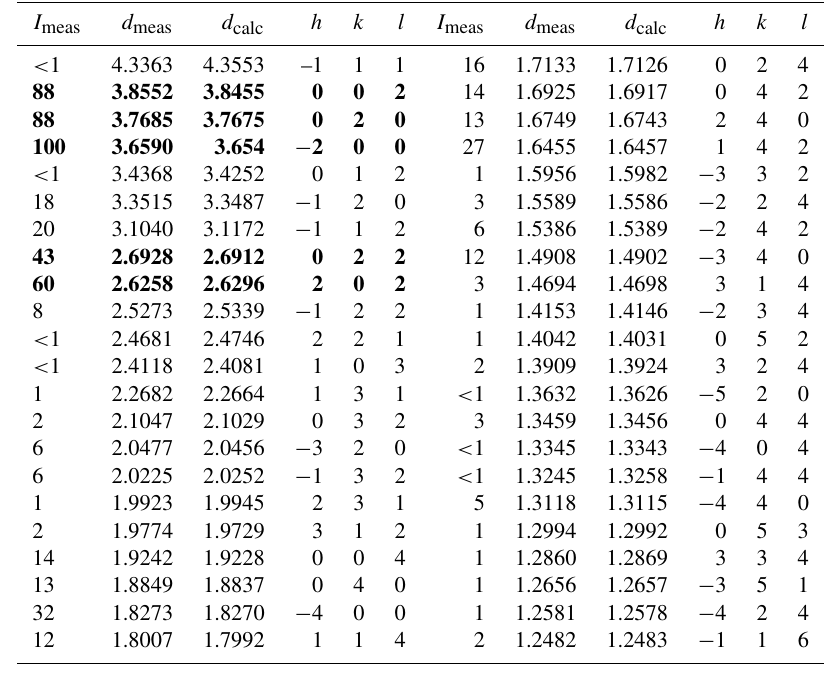
Table 2. X-ray powder diffraction data ( d in Å) for liguowuite.